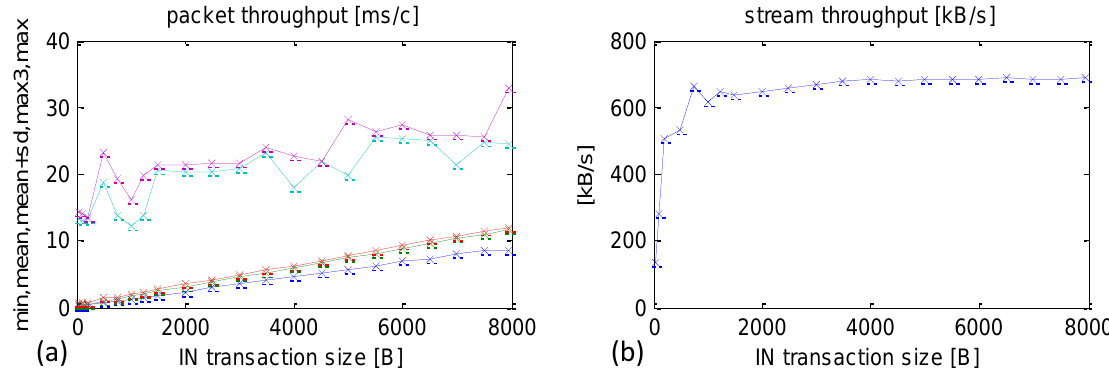
Figure 14. Experimental results depending on packet size measured after optimisation. Dual-thread architecture. ( a ) min, mean, mean + SD, max3, max CCLT depending on packet size. ( b ) Sensors datastream depending on packet